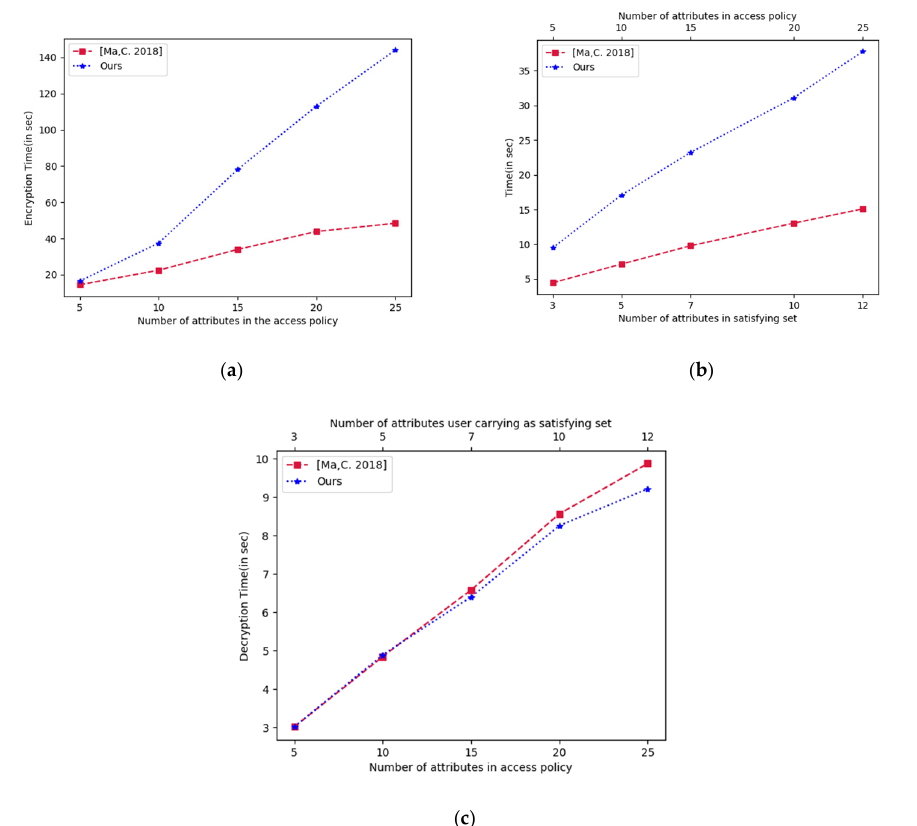
Figure 3. ( a ) Encryption time, ( b ) attribute key generation time, ( c ) decryption time .